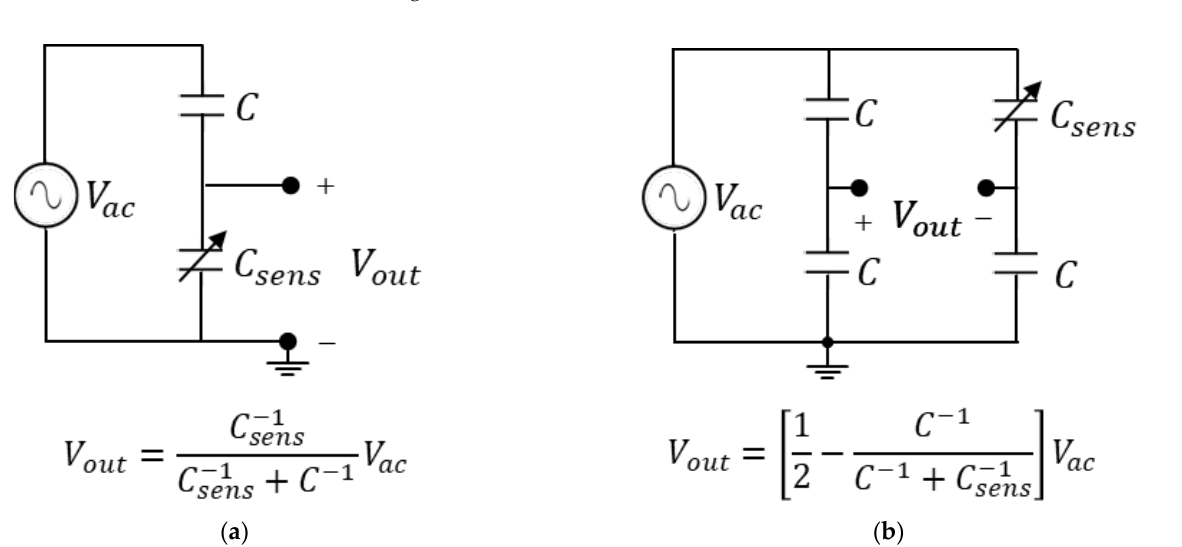
Figure 7. Traditional interfaces for resistive sensors. ( a ) Resistive voltage divider; ( b ) resistive Wheatstone bridge.